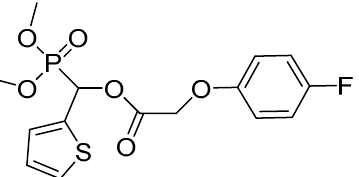
Figure 8. Structure of a potent 1-(substituted phenoxyacetoxy)alkylphosphonate that targets pyruvate dehydrogenase complex (PDHc).